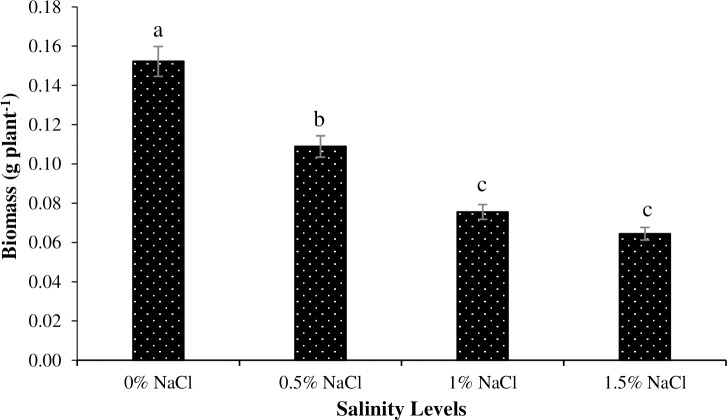
The influence of different NaCl salinity levels on dry biomass production of Basil (Ocimum basilicum L.).The vertical bars are means ± standard errors. Any two means having different letters are statistically different from each other (p < 0.05).